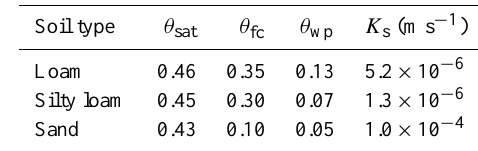
Table 4. Parameters for different soil types (Shu et al., 2012), θ sat is water content at saturation, θ fc is water content at field capacity, θ wp is water content as wilting point and K s is saturated hydraulic